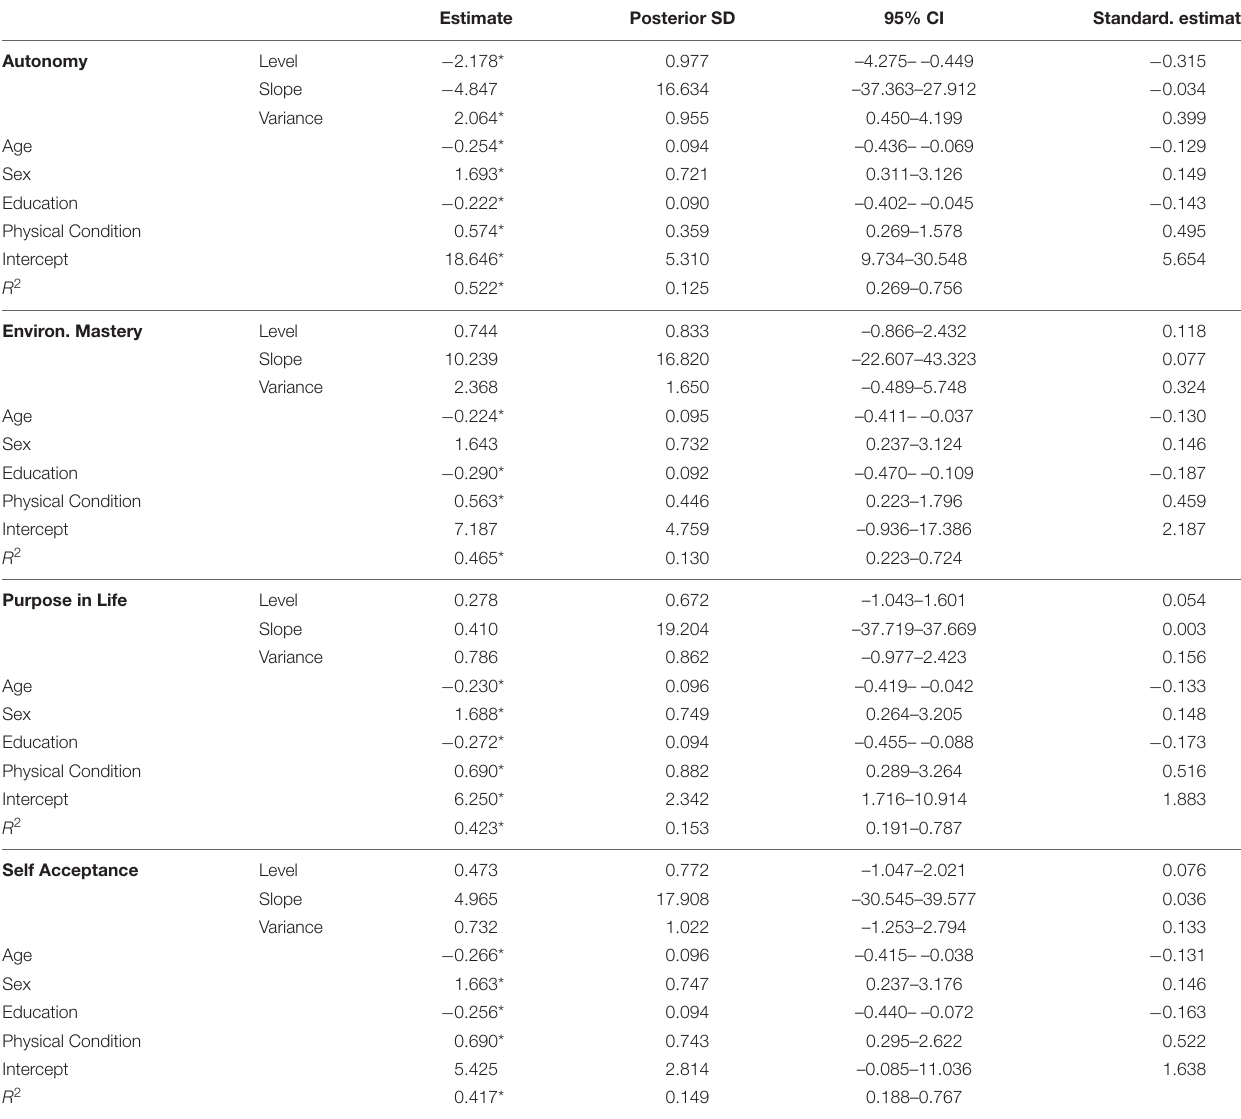
TABLE 3 | Multilevel SEM between-person regressions of time-to-death at baseline on autonomy, environmental mastery, purpose in life, and self-acceptance. Estimate Posterior SD 95% CI Standard.